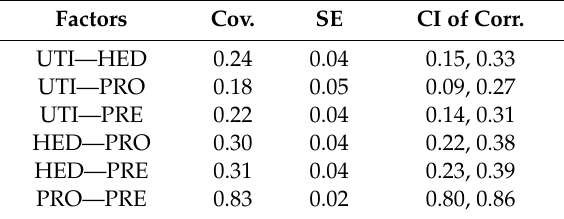
Table 2. Discriminant validity of instruments.